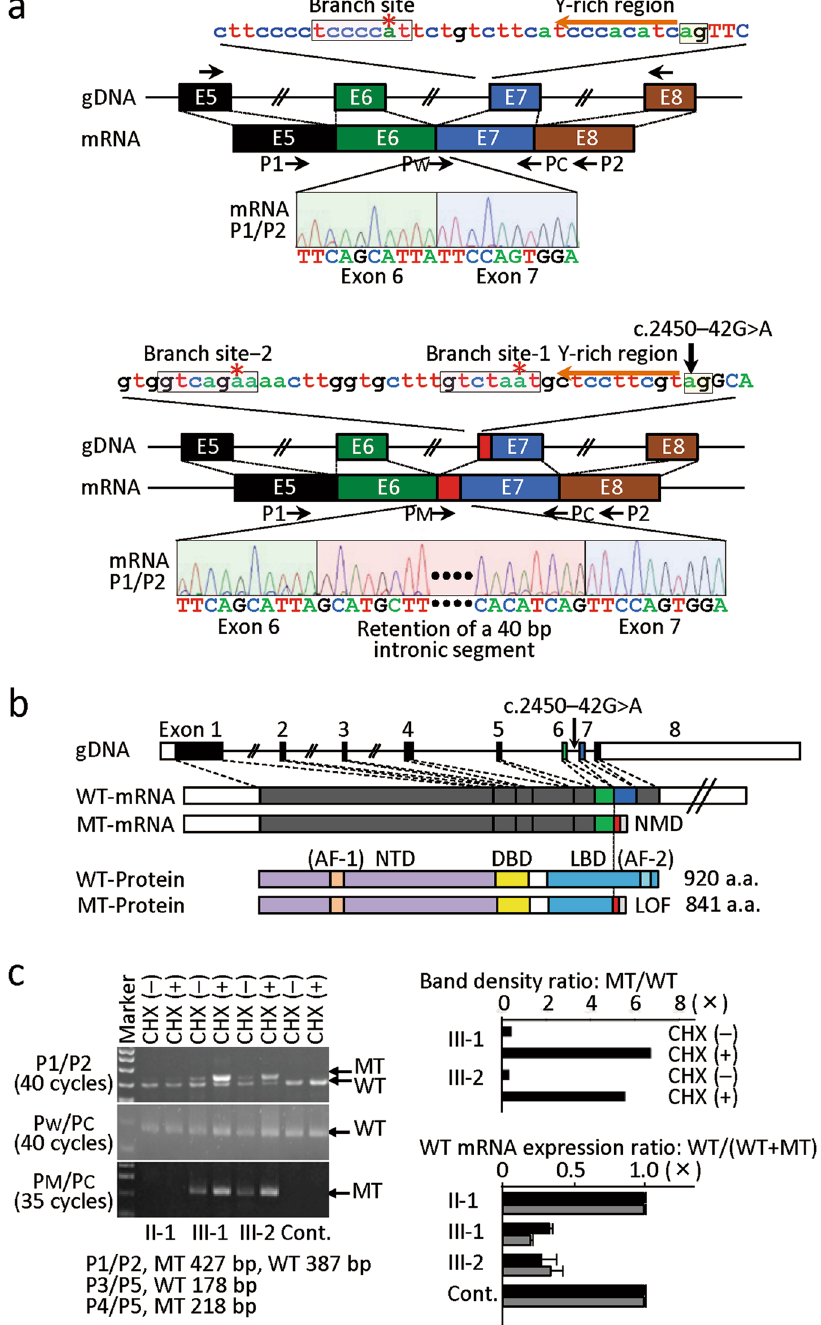
Figure 2. Alternative splicing caused by the c.245–42 G > A variant creating the “AG” splice acceptor site. ( a ) Normal splicing identified in the affected boys (III-1 and III-2). Normal splicing has occurred using the wildtype “AG” splice acceptor motif, pyrimidine (Y)-rich sequence, and the branch site, generating wildtype mRNA, whereas aberrant splicing has taken place using the newly created “AG” splice acceptor motif that is associated with pyrimidine (Y)-rich sequence and two putative branch sites, producing mRNA with retention of a 40 bp intronic segment (highlighted with red) between exon 6 (highlighted with green) and exon 7 (highlighted with blue). Red asterisks indicate the highly conserved “A” nucleotide at branch sites. Exonic and transcribed intronic nucleotides are written with large letters, and intronic nucleotides with small letters. ( b ) Schematic representation of AR exons on the genome, and wildtype (WT) and mutant (MT) mRNA and protein. AF-1: activation function 1; NTD: N-terminal transactivation domain; DBD: DNA binding domain; LBD: ligand binding domain; and AF-2: activation function 2. The coding regions are shown with solid boxes, and the untranslated regions are depicted with open boxes; exon 6, exon 7, the transcribed intronic sequence, and the frameshifted sequence before the premature termination are shown in green, blue, red, and gray, respectively. It is predicted that the mutant mRNA primarily undergoes nonsense mediated decay